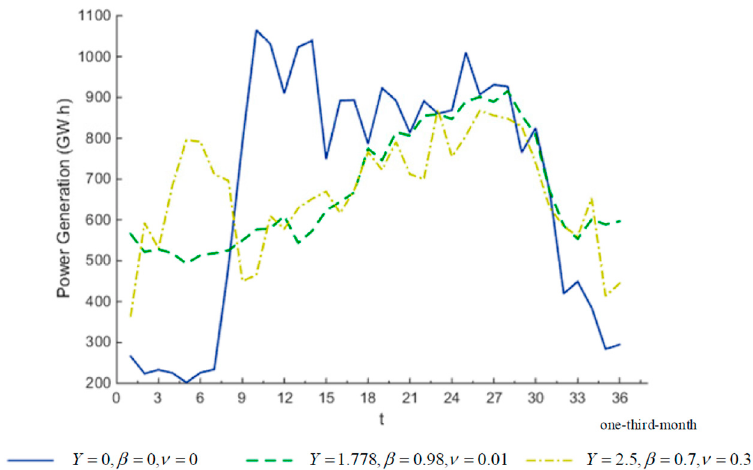
Figure 2. Averaged power generation trajectory by simulation with ( Y , β , ν ) = (0, 0, 0), (1.778, 0.98, 0.01), and (2.5, 0.7, 0.3), respectively.